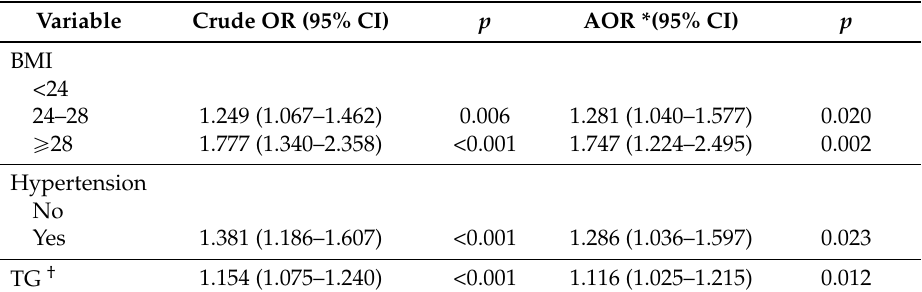
Table 4. Factors associated with pre-diabetes in multivariate logistic regression